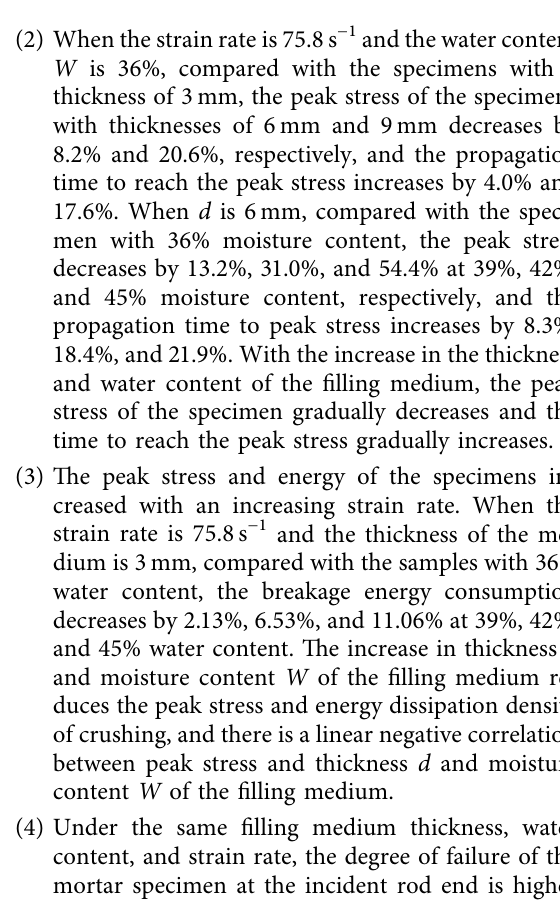
Figure 13: Failure modes of composite specimens with diferent flling media thicknesses and water contents. (a) d � 3mm. (b) d � 6mm. (c) d �